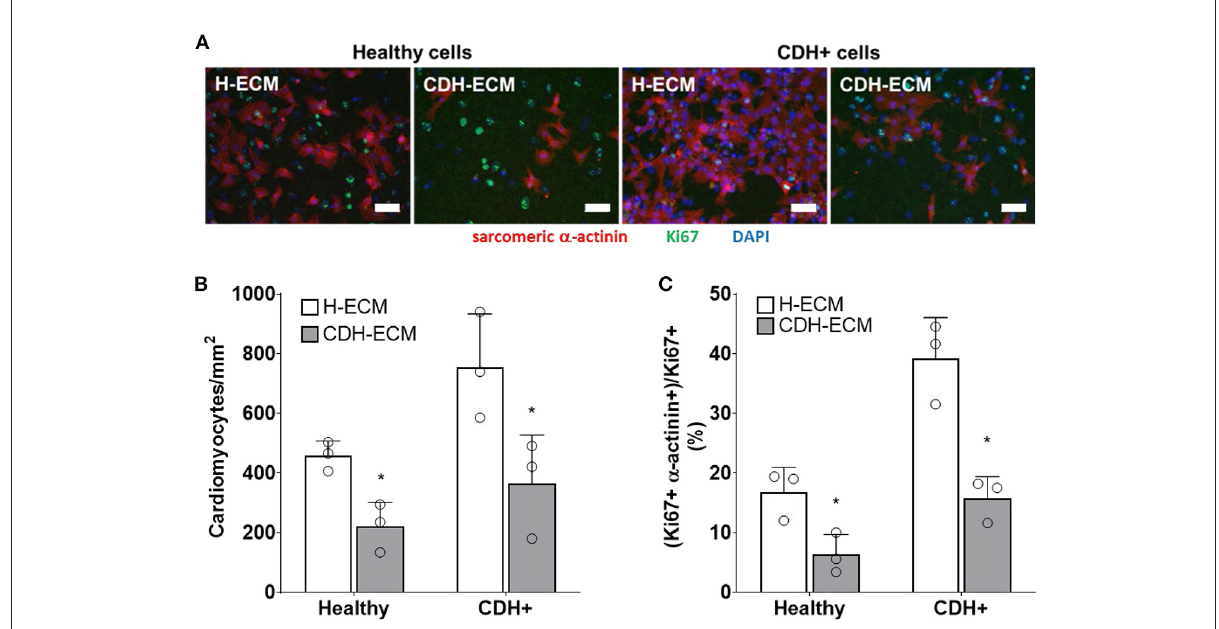
FIGURE5 Cardiomyocyte response to ECM. (A) Representative images of cells on ECM derived from healthy hearts (H-ECM) and CDH + hearts (CDH-ECM), stained for Hoechst (blue), Ki67 (green), and cardiac α -actinin (red). (B) Cardiomyocyte density and (C) cardiomyocyte proliferation were significantly decreased in both healthy and CDH + populations on CDH-ECM after 4 days in culture. Graphs show mean ± SD ( n = 3). In all cases * denotes p <